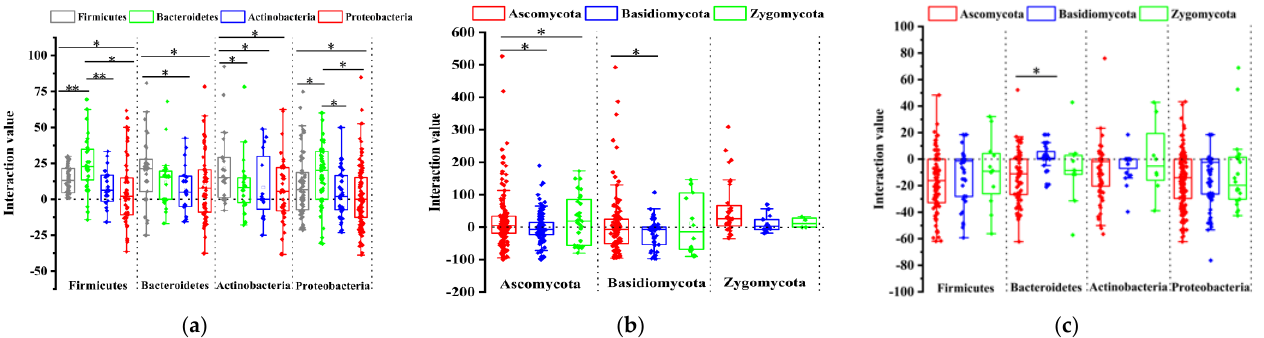
Figure 4. Interactions of representative bacterial and fungal isolates. ( a ) Box-plot analysis of endophytic bacterial interactions at the taxonomic level of the phylum. ( b ) Box-plot analysis of endophytic fungal interactions at the taxonomic level of the phylum. ( c ) Box-plot analysis of the interaction between endophytic bacteria and fungi at the taxonomic level of the phylum. Asterisks indicate significant differences between the group: ** P < 0.01, * P < 0.05, nonparametric test, Wilcoxon signed rank test. Three biological replicates per treatment were used for analysis. Error bars represent the SEM.